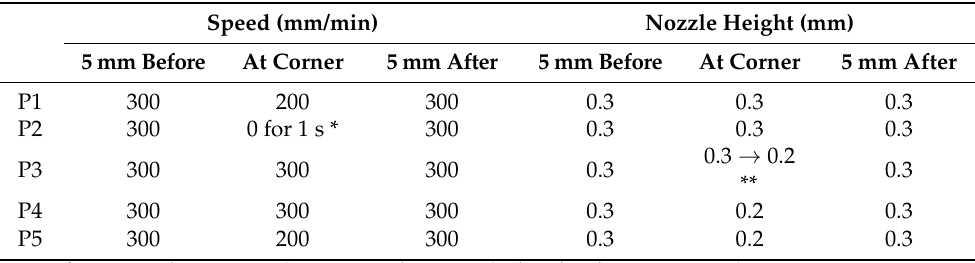
Table 1. Printing parameter adjustment to tackle the 90 ◦ turning